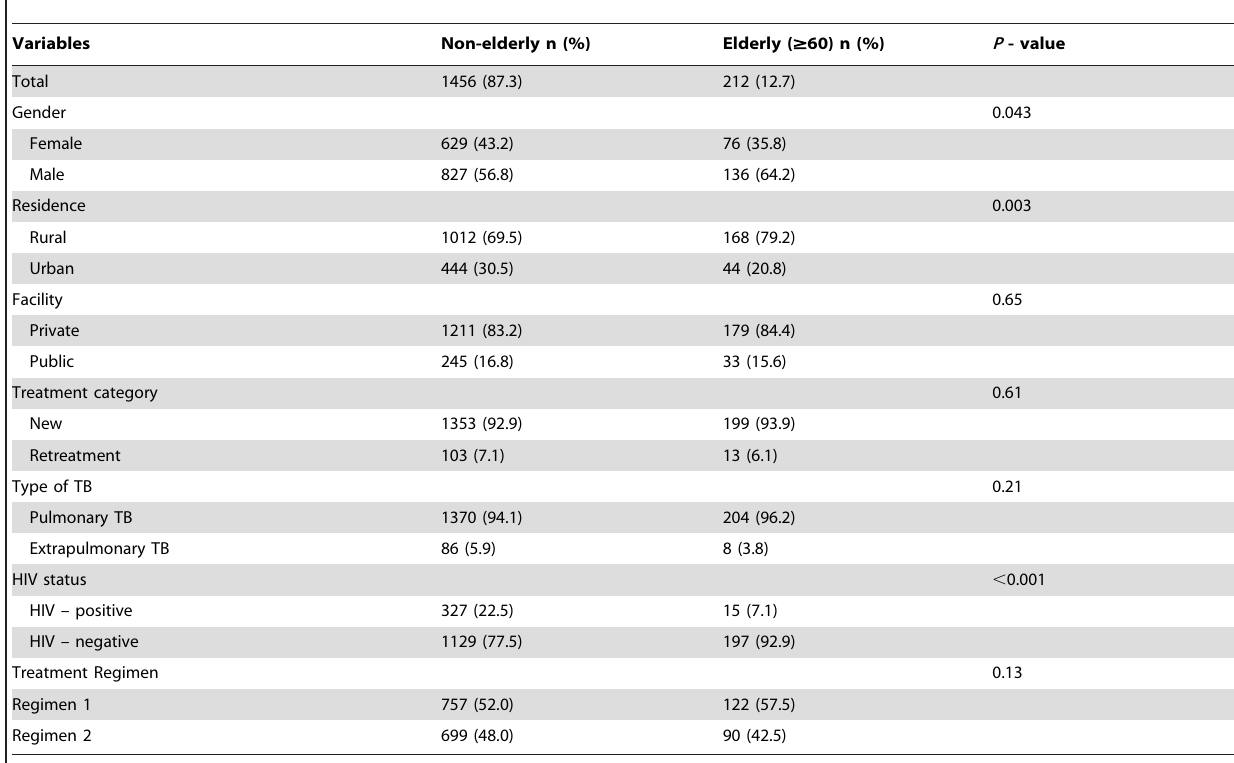
Table 1. Demographic and clinical profile of elderly versus non-elderly TB patients, Nigeria,